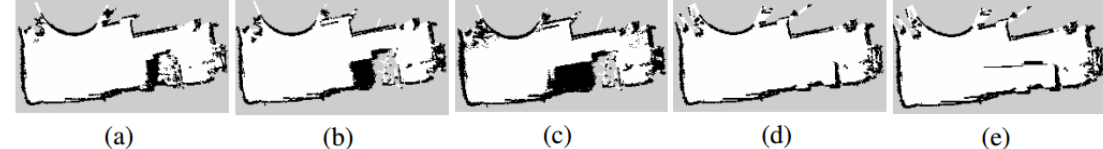
Figure 12. Multilayer maps and the traversable map for the real-world environment. ( a – d ) Multiple projected layers from OctoMap; ( e ) the traversable map. The staircases and slope edge are occupied while the slope is the free